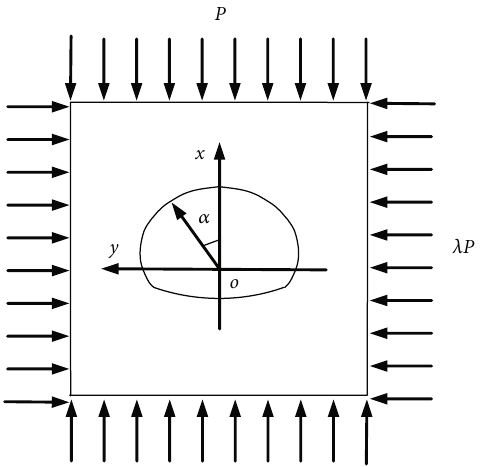
Figure 1: Schematic diagram of the noncircular